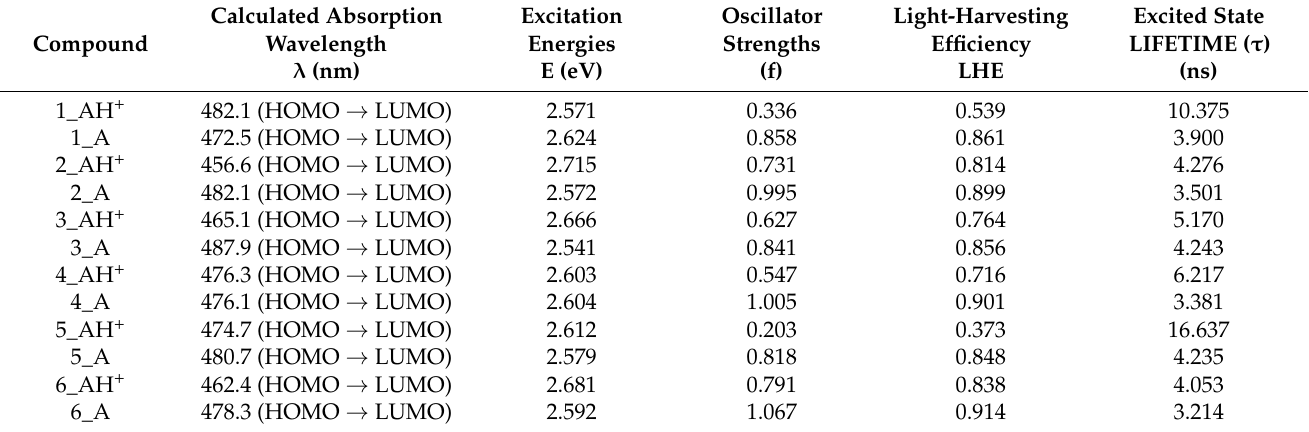
Table 2. The calculated excitation energies, E (eV), the oscillator strength, f, the absorption wavelength, λ (nm), and light-harvesting efficiency,